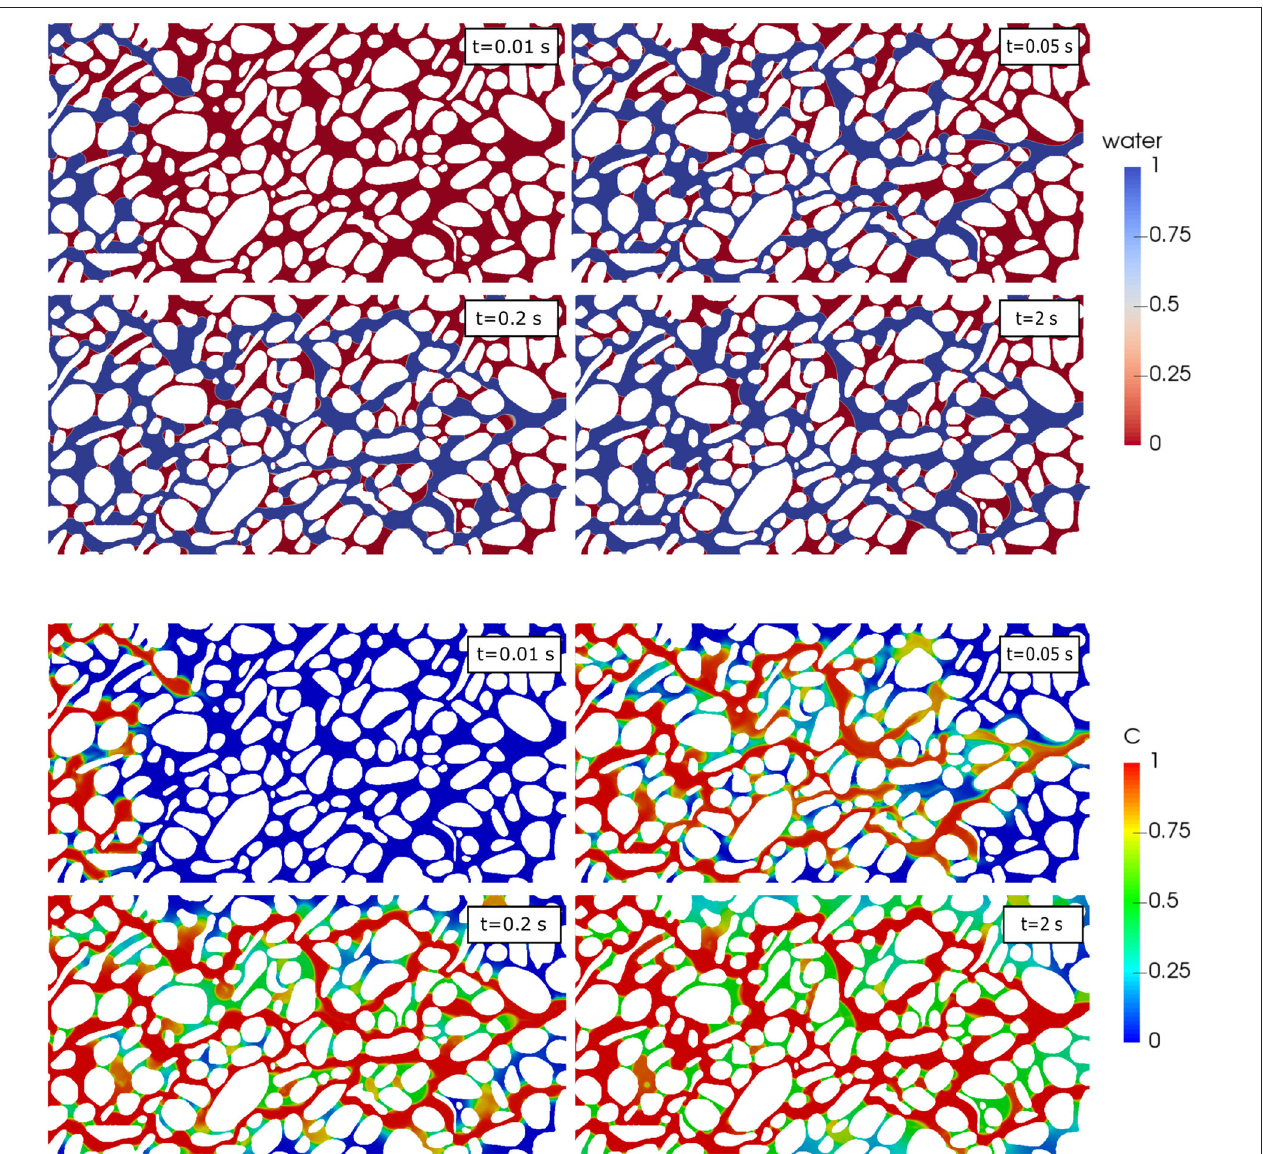
FIGURE 7 | Simulation results of drainage of oil (wetting phase) by water with multi-component mass transfer at the pore-scale. The white pillars correspond to the solid grains. Top: distribution of the fluid phases during the drainage at different timestep. Bottom: concentration profile in the system (adapted from Maes and Soulaine,